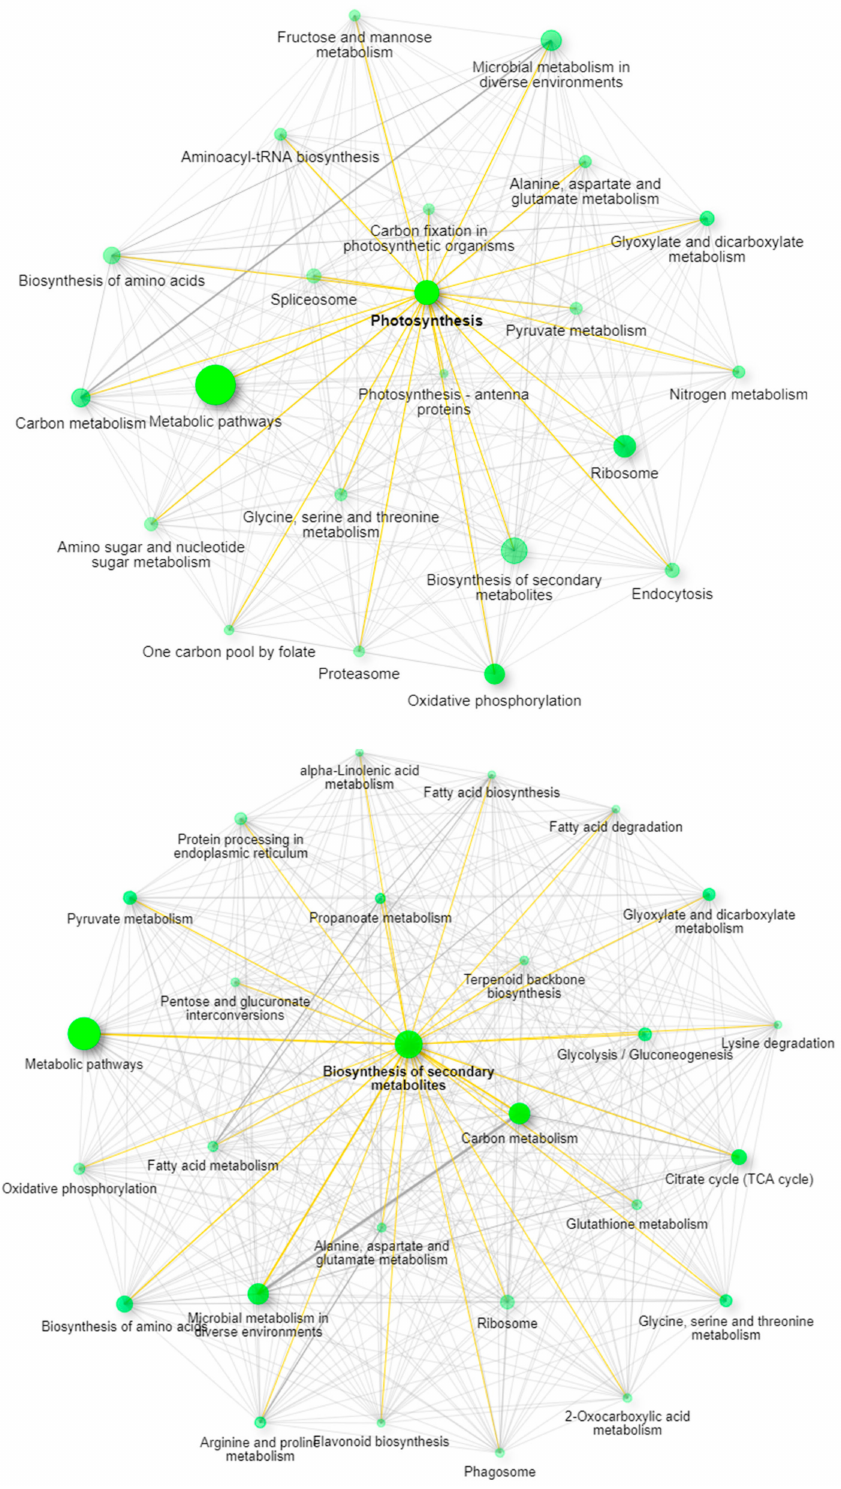
Figure 2. ShinyGO network analysis demonstrating the pathway di ff erences between leaves (top panel) and mature female flowers (bottom